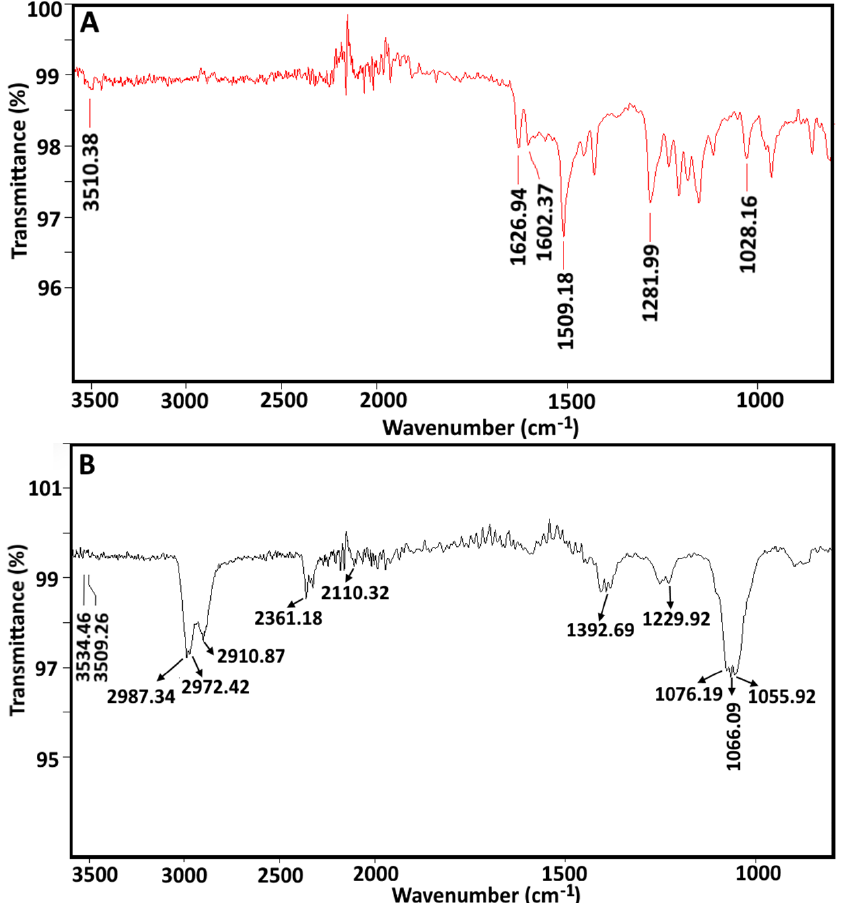
Figure 3. FTIR spectrum of samples: pure curcumin ( A ) and CHBs ( B ). FTIR, Fourier transform infrared; CHBs, curcumin hydrogel beads.